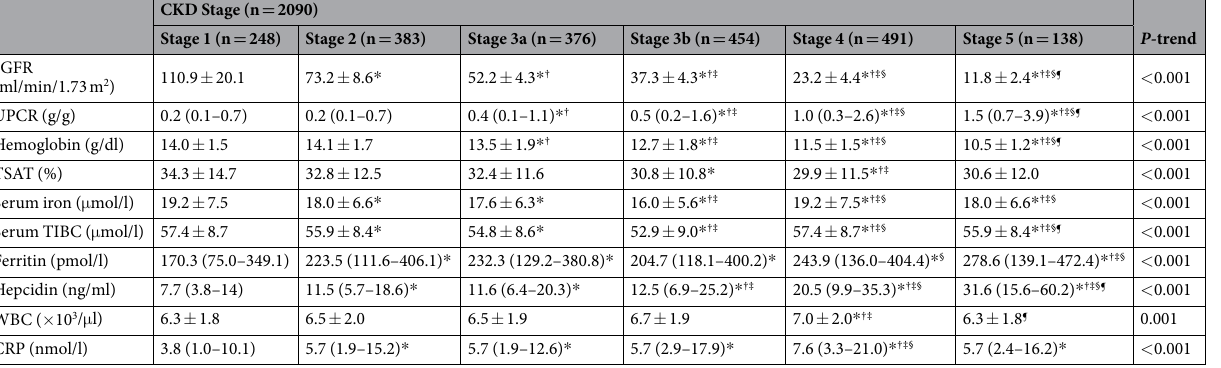
Table 2. Trends of hemoglobin, iron metabolism and inflammation by the stage of chronic kidney disease. CKD, chronic kidney disease; eGFR, estimated glomerular filtration rate; UPCR, urine protein-to-creatinine ratio; TSAT, transferrin saturation; WBC, white blood cells; CRP, C-reactive protein. Values are expressed as mean ± standard deviation for normally distributed continuous variables and median (interquartile range) for non-normally distributed continuous variables. P -trend was analyzed by a linear-term of one-way ANOVA for normally distributed variables and Jonckheere-Terpstra test for non-normally distributed variables. * ,†,‡,§ , and ¶ meant P < 0.05 when compared to CKD stage 1, 2, 3a, 3b, and 4, respectively, by using Bonferroni post-hoc analysis of one-way ANOVA for normally distributed variables and Mann-Whitney U test for non-normally distributed